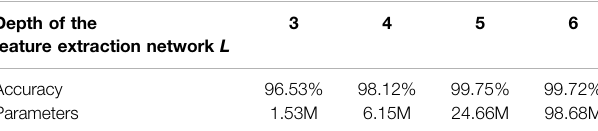
TABLE 6 | Diagnostic accuracy of MSDFN of different depth feature extraction